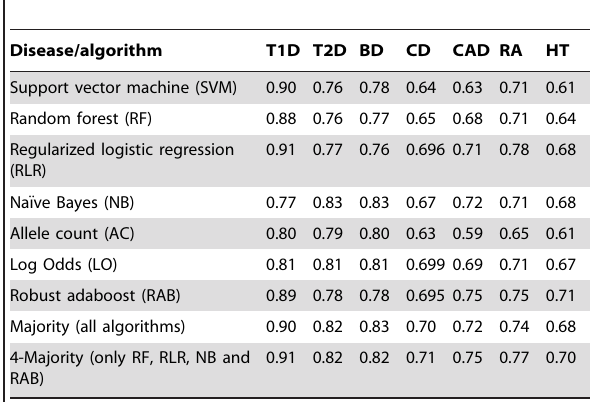
Table 2. Mean test AUC for different algorithms using